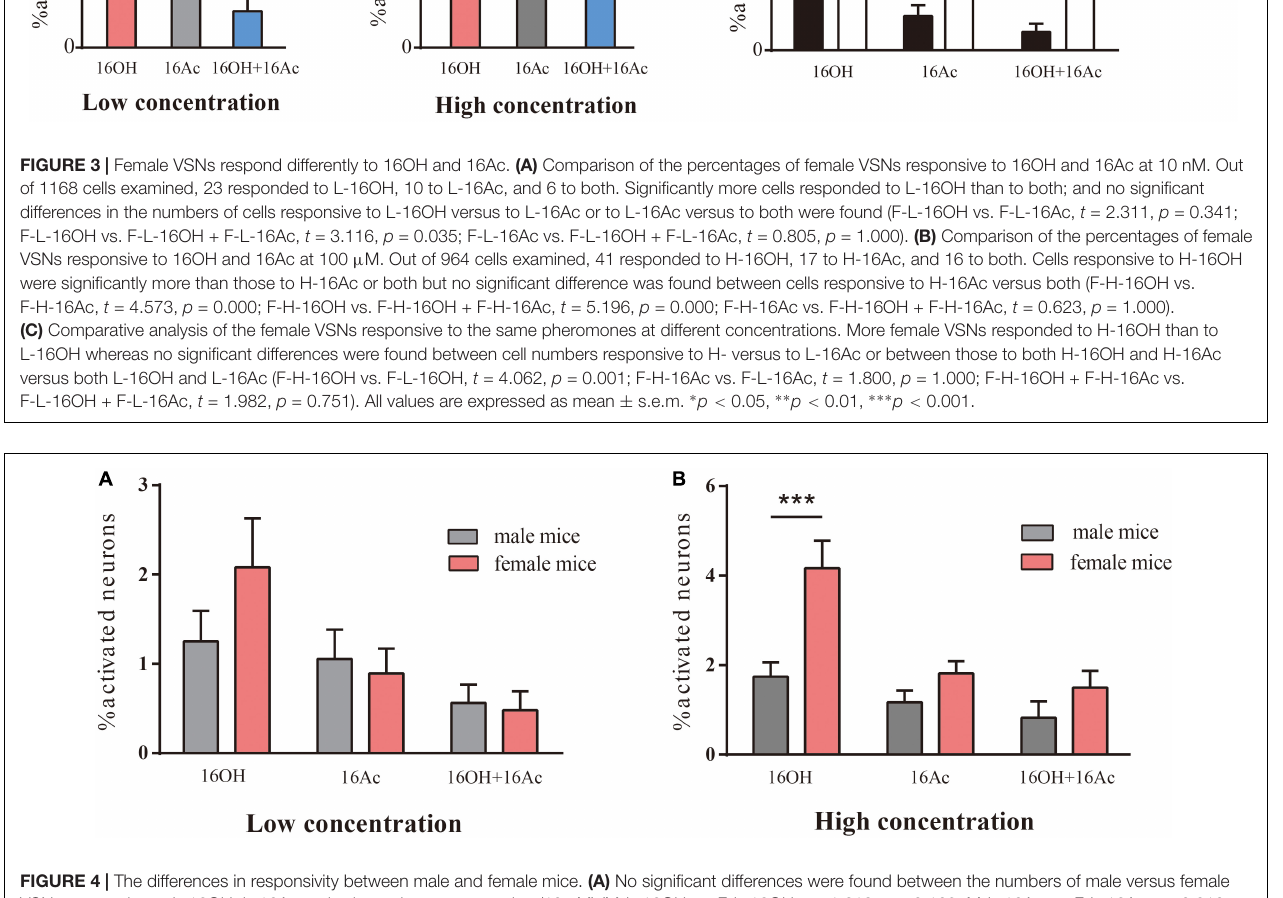
FIGURE 4 | The differences in responsivity between male and female mice. (A) No significant differences were found between the numbers of male versus female VSNs responsive to L-16OH, L-16Ac, or both at a low concentration (10 nM) (M-L-16OH vs. F-L-16OH, t = 1.618, p = 0.109; M-L-16Ac vs. F-L-16Ac, t = 0.310, p = 0.757; M-L-16OH + M-L-16Ac vs. F-L-16OH + F-L-16Ac, t = 0.160, p = 0.873). (B) Significantly more female VSNs responded to H-16OH than male VSNs whereas no significant differences were found between the numbers of male and female responsive cells to H-16Ac or to both (100 µ M) (M-H-16OH vs. F-H-16OH, t = 4.726, p = 0.000; M-H-16Ac vs. F-H-16Ac, t = 1.254, p = 0.213; M-H-16OH + M-H-16Ac vs. F-H-16OH + F-H-16Ac, t = 1.314, p = 0.192). All values are expressed as mean ± s.e.m. ∗∗∗ p <